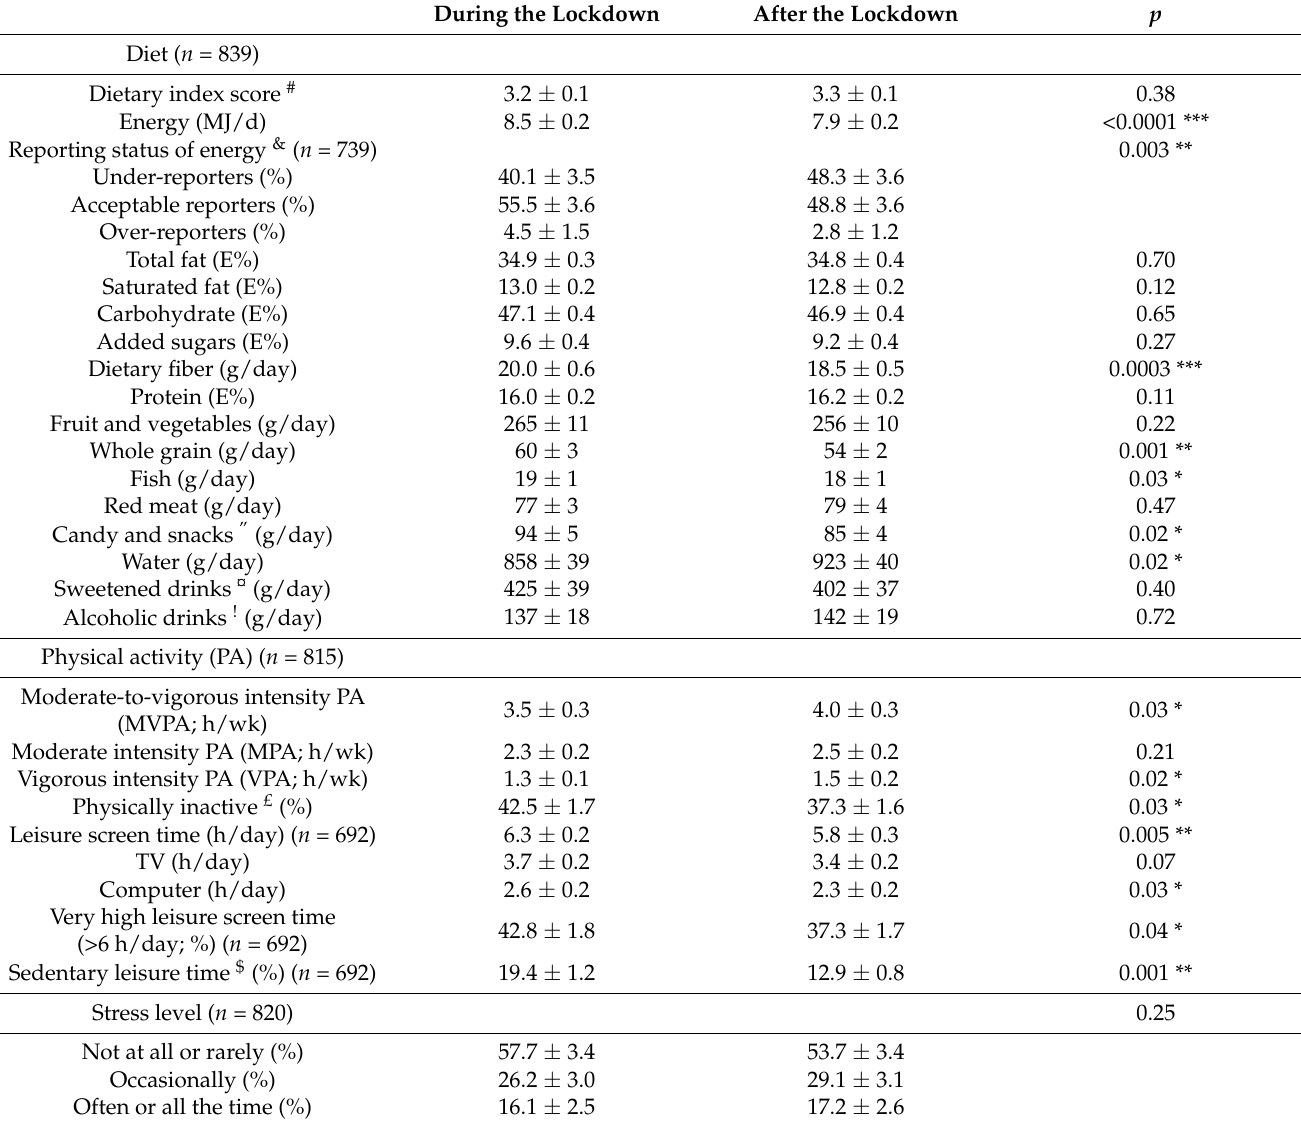
Table 2. Change in diet, physical activity, and stress level among Danish adults assessed during and after the lockdown using descriptive statistics (mean/percentage ± SEM). During the